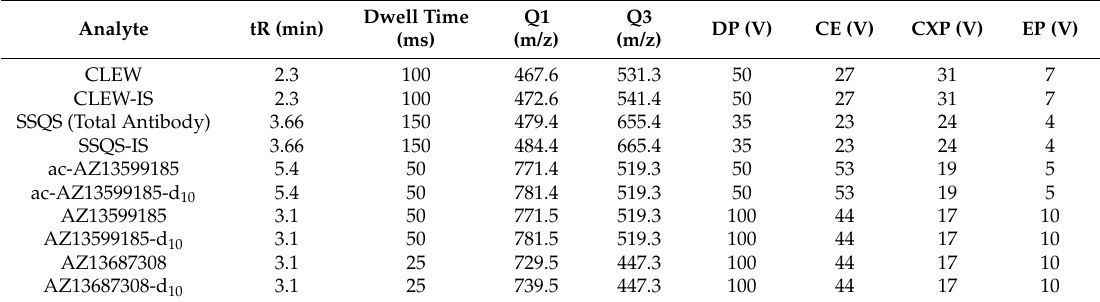
Table 1. Tandem mass spectrometry (MS/MS) parameters ABI SCIEX API 5000.